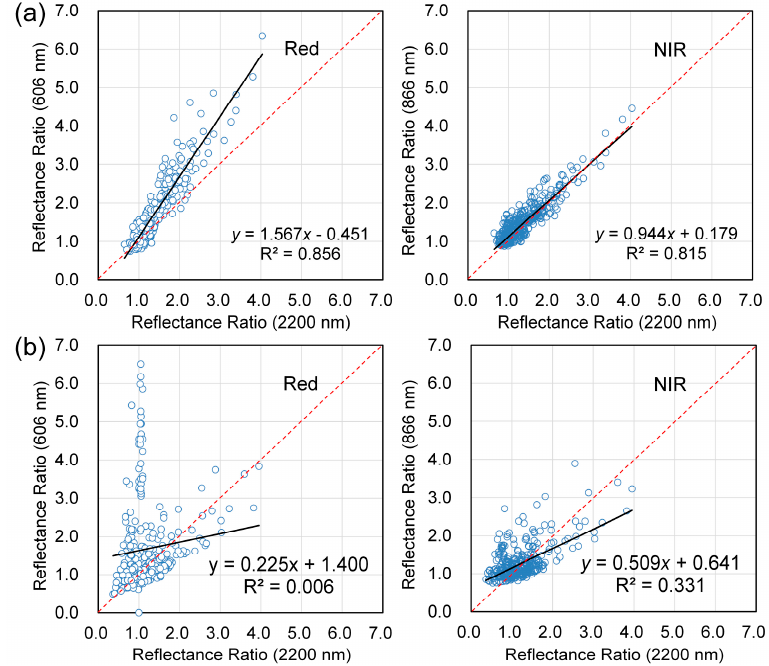
Figure 1. The performances of reflectance ratios at the mid-infrared band (2200 nm) to approximate those at the red band (606 nm) and those at the near-infrared band (866 nm) for ( a ) the bog and ( b ) the forest land cover types.